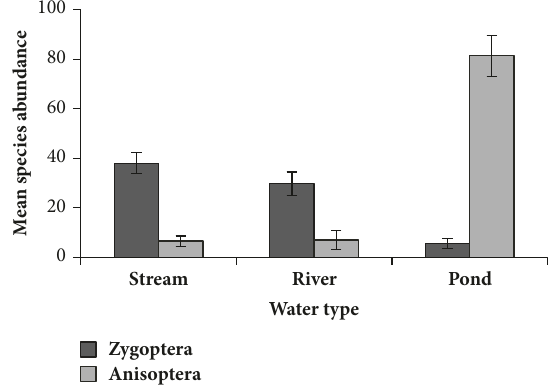
Figure 4: Comparison of mean species abundance of Zygopterans and Anisopterans among the water types.